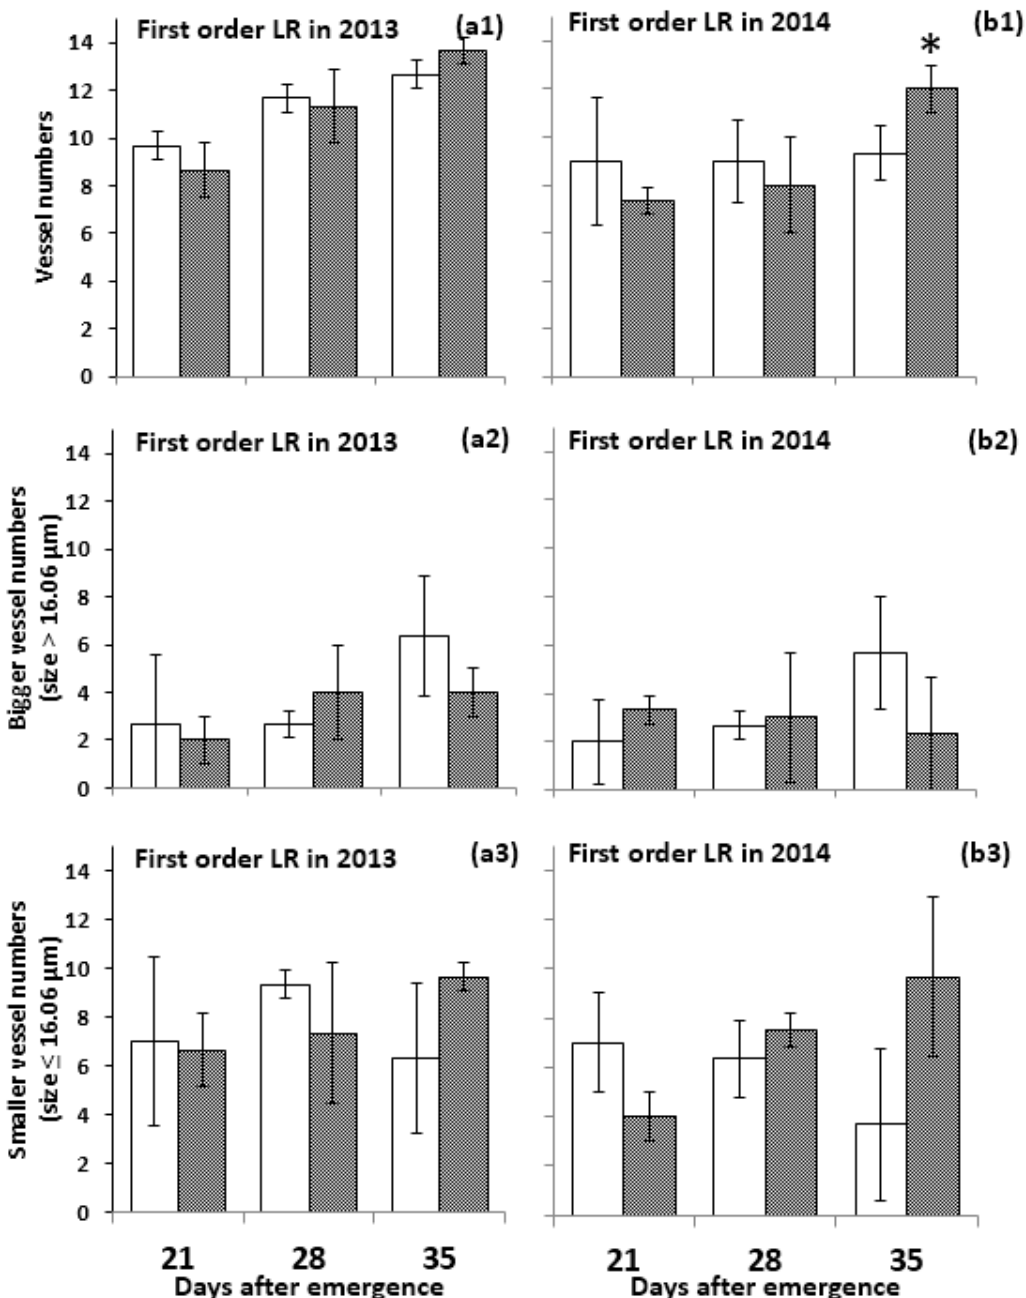
Figure 4. Vessel numbers of first order lateral roots ( a1 , b1 ), bigger vessel number ( a2 , b2 ) and smaller vessel number ( a3 , b3 ) of peanut at 21, 28 and 35 DAE in 2013 ( a ) and in 2014 ( b ); Significant at * p ≤ 0.05, non-stress treatments ( □ ) and stress treatments ( ■ ).